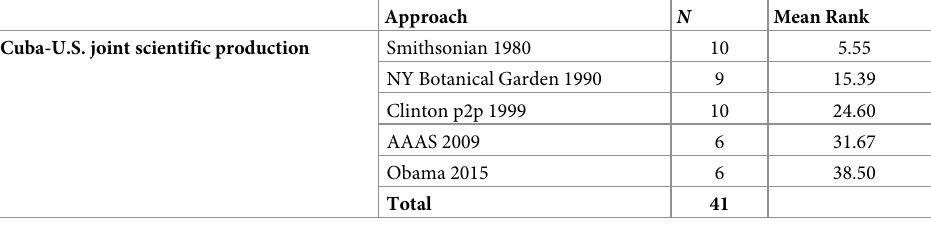
Table 3. Mean rank of Cuba–U.S joint scientific productivity during each U.S. approach.